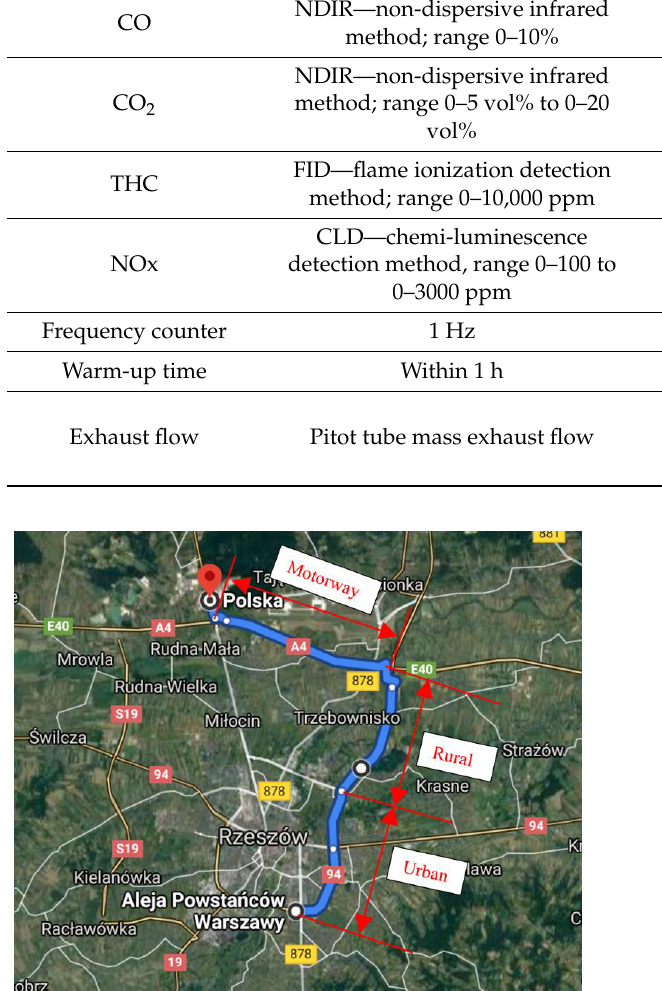
Figure 3. View of the test road (blue line).